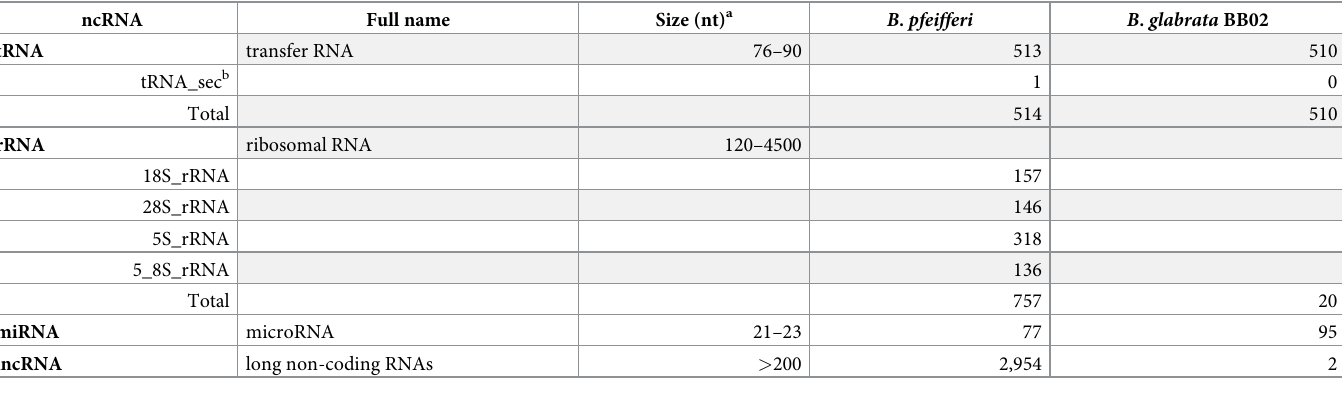
Table 4. Predicted non-coding RNAs in Biomphalaria genomes.